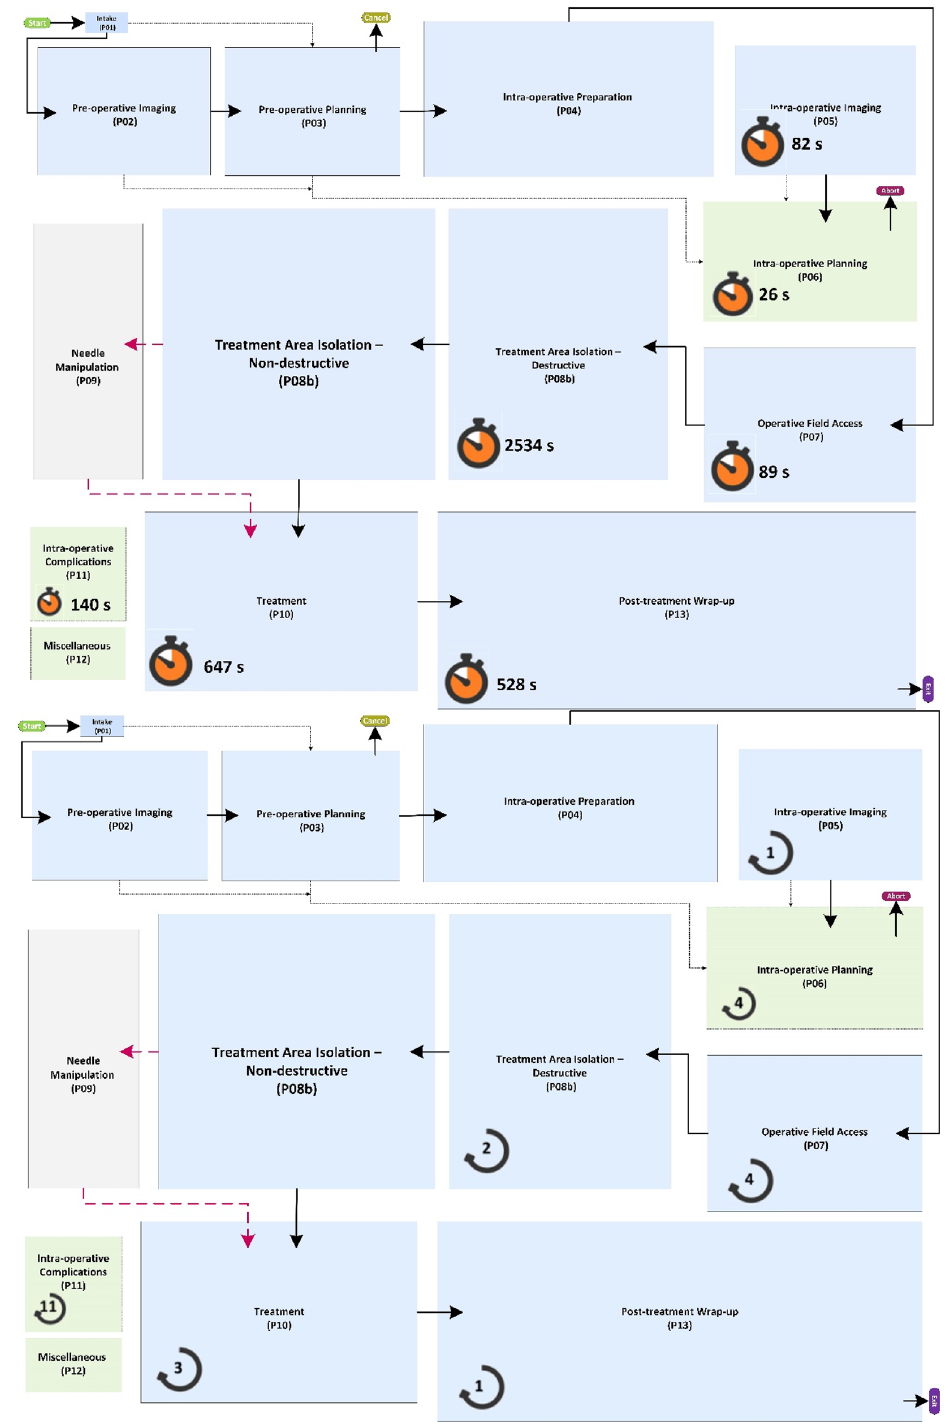
Figure 6. Generic surgical process model view at the phase level for duration and occurrence frequency of different phases for a sample surgery presented in Supplementary material-part S2 (type: parenchyma sparing of a tumor in Segments 5 and